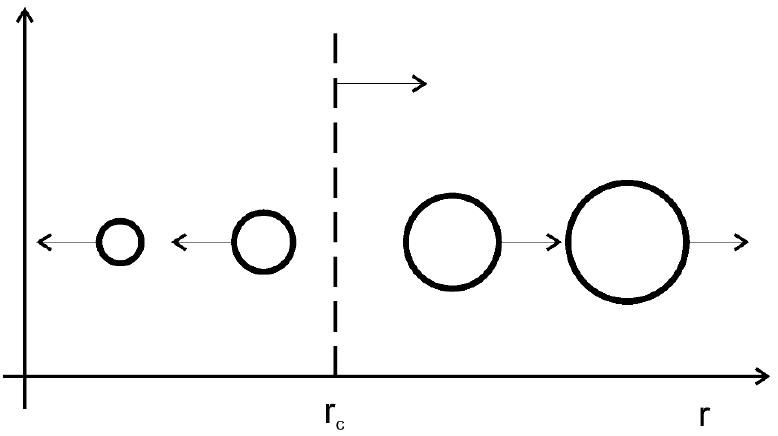
Figure 5. Scheme of diffusion coalescence. Big particles grow, small particles dissolute. Supersaturation decreases and critical radius grows with time. Consequently, the number of particles decrease. According to L-S-W theory